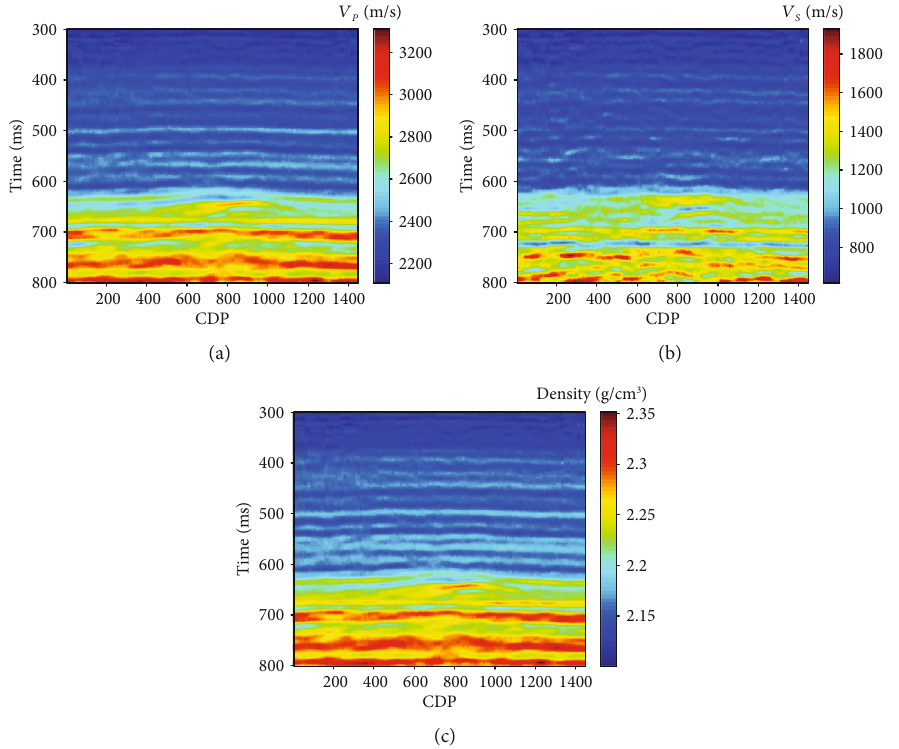
V P , (b) S , and (c) density.